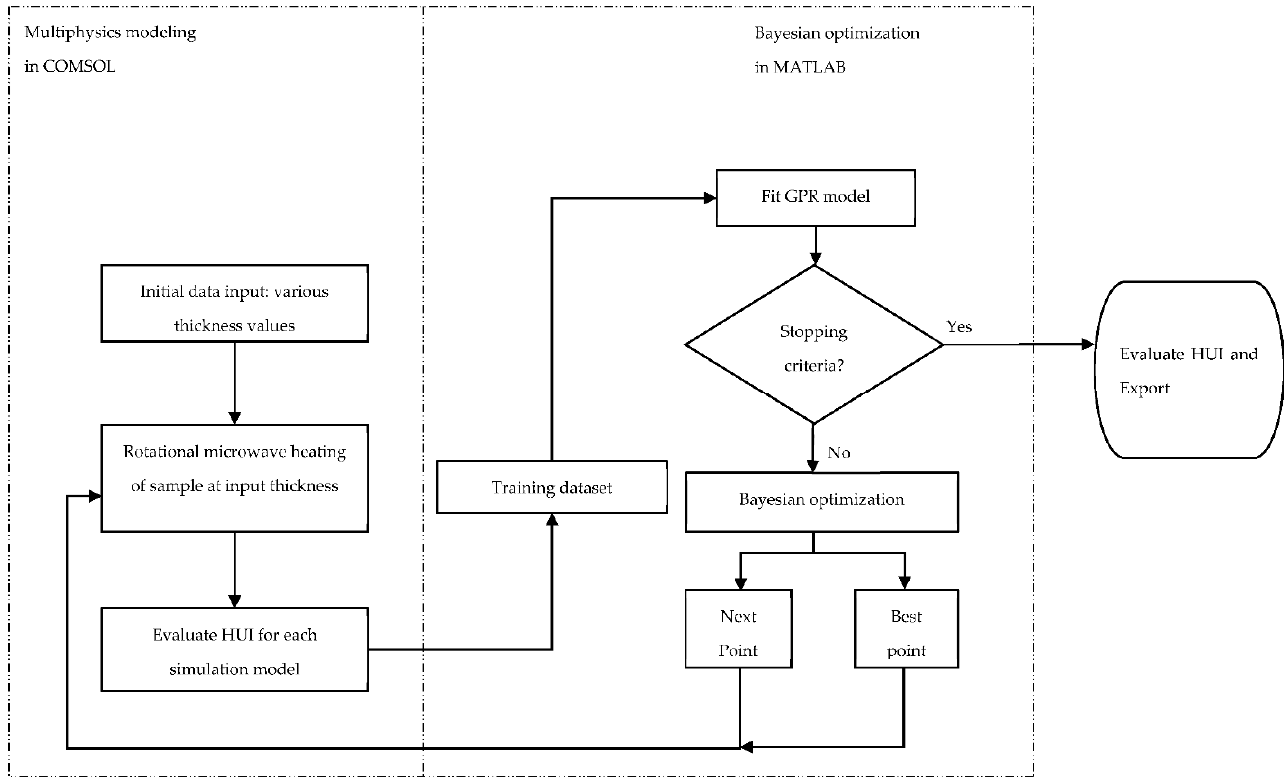
Figure 3. Proposed integrated approach that combines mechanistic-modeling and Bayesian optimization-based machine- learning. (GPR: Gaussian process regression; HUI: Heating uniformity index).